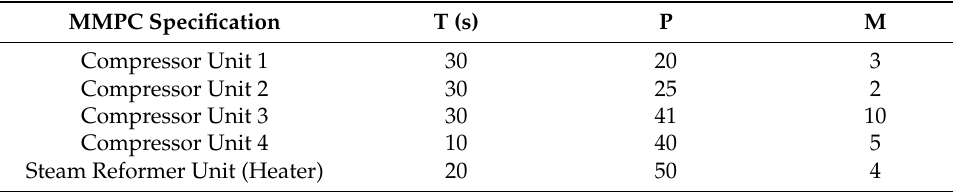
Table 3. MPC control parameters from previous research.